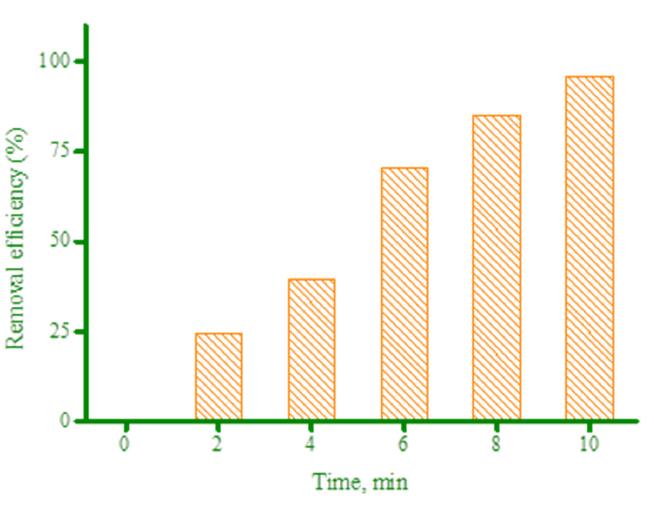
Figure 13. Removal efficiency (%) of MV (1 mg in 100 mL of deionized water) using 40 mg of the fullerene CNT at different contact times.